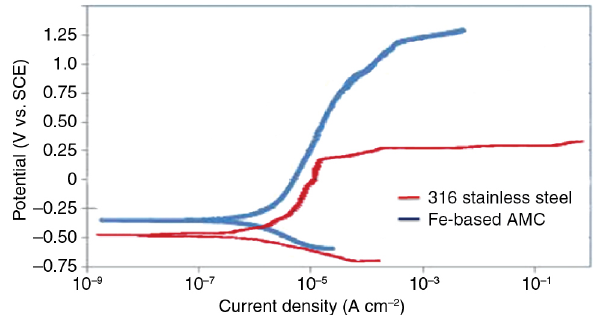
Figure 8: Potentiostatic polarisation curves in 3.5 wt.% NaCl solutions for 316 stainless steel and an Fe-based amorphous coating.